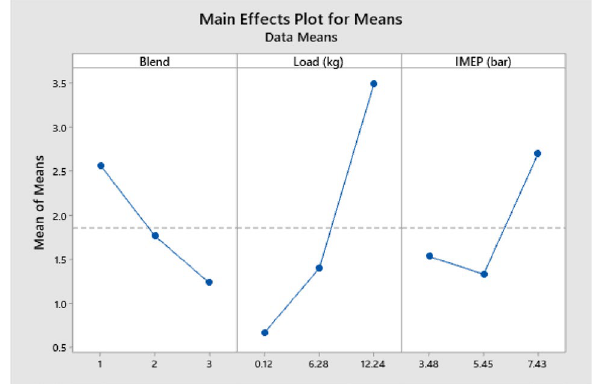
Fig. 8 Investigation by Taguchi: CO